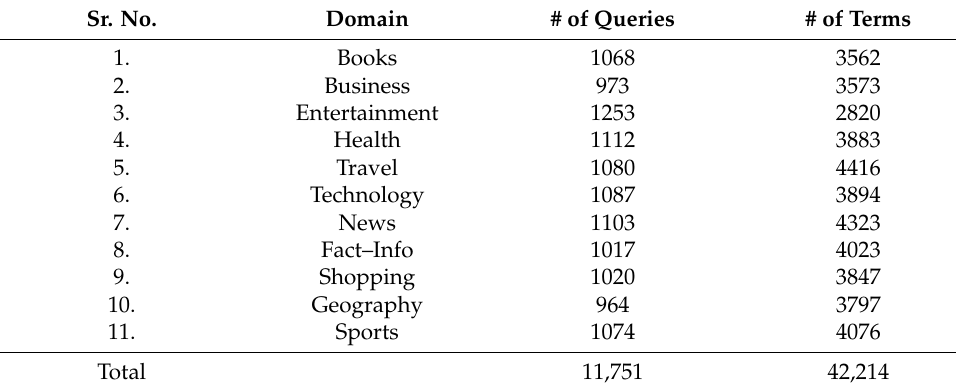
Table 2. Domain-wise distribution of Urdu web